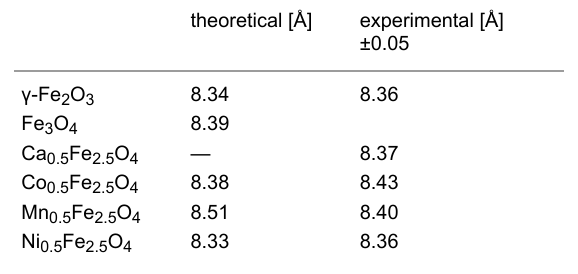
cle diameter can be calculated by the Scherrer equation (Equa- tion 1). The obtained values are given together with TEM values in Table 1.